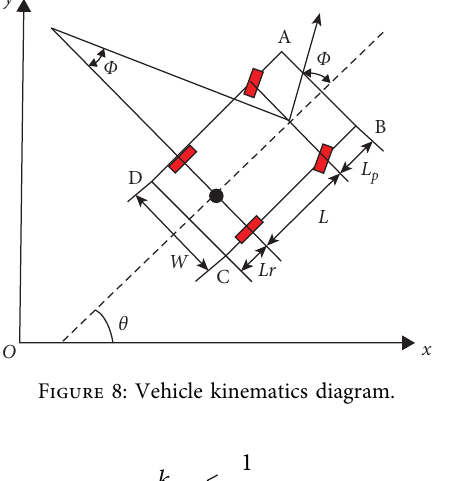
Figure 8: Vehicle kinematics